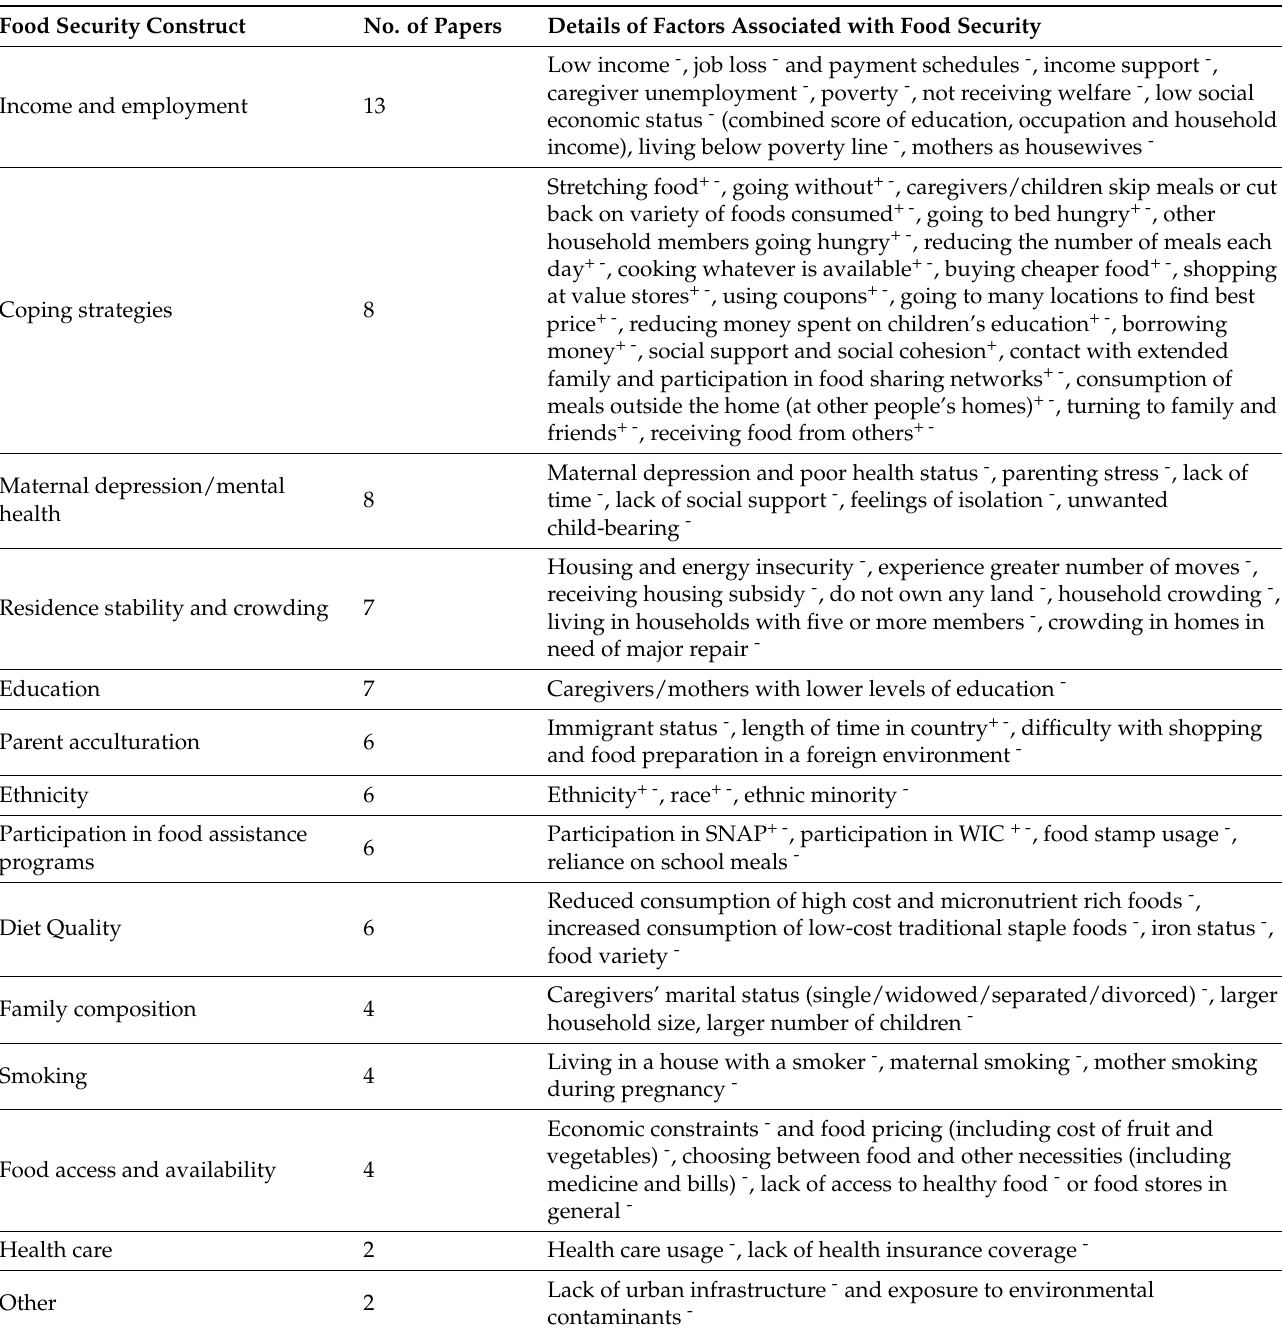
Table 2. Summary of constructs associated with food security arising from the